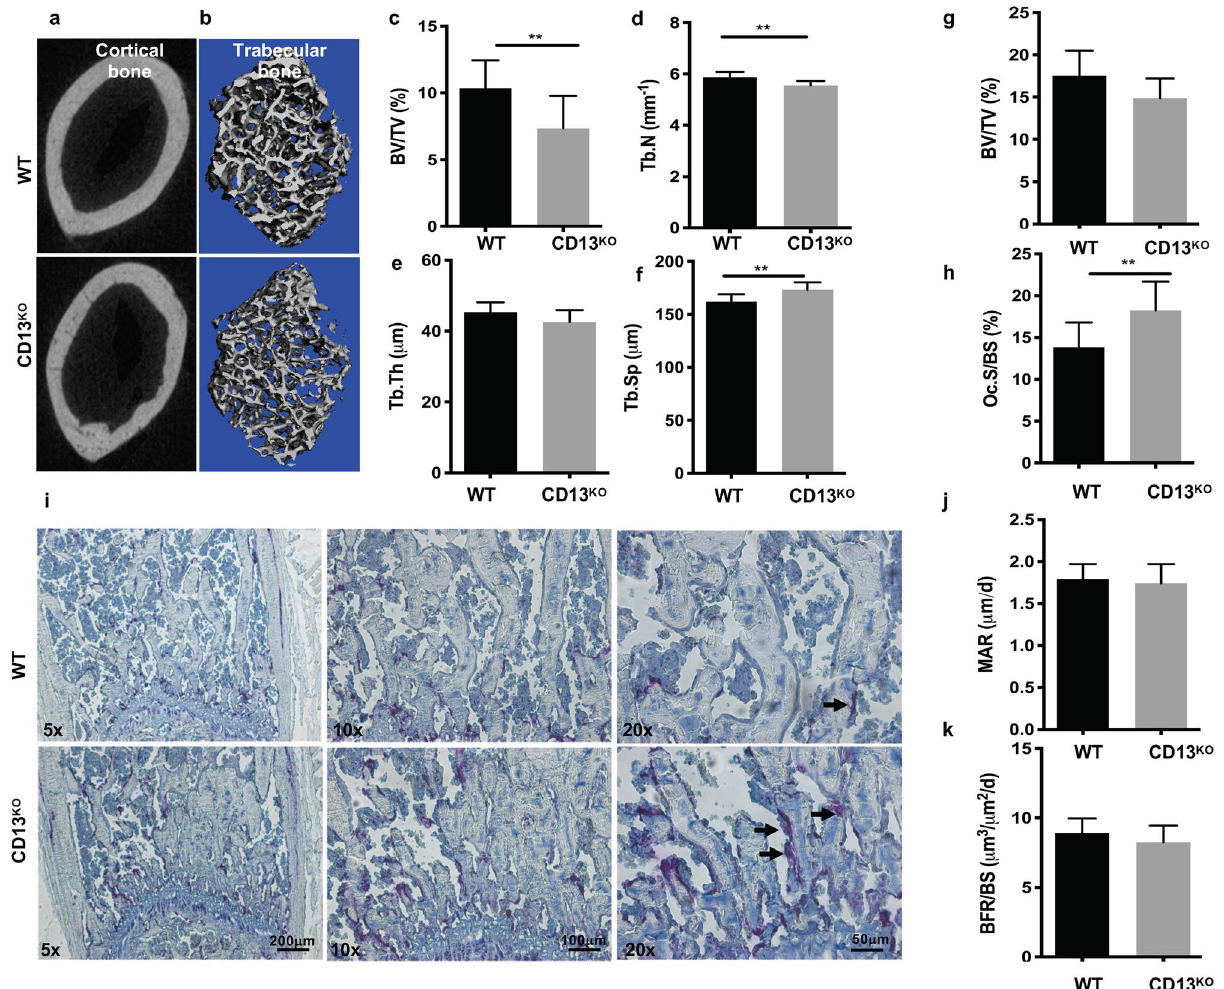
femurs with ( g ), BV/TV(%), ( h ) Oc.S/BS; % OCs per bone surface ( i ), histochemical detection of TRAP + osteoclasts (purple, indicated by the arrow). ( j ) Mineral apposition rate (MAR), ( k ) Bone formation rate (BFR/ BS) measured by Osteomeasure software (OsteoMetrics, Decatur, USA) (https:// www. osteo metri cs. com). All samples were scanned, reconstructed, and analyzed in a Scanco µCT40 running Evaluation Program V6.6 (http:// www. scanco. ch/ en/ syste ms- solut ions/ softw are. html). Histochemical analysis of TRAP + osteoclasts in bone sections were imaged with Zeiss fluorescence inverted microscope and analyzed by using Zeiss Zen 2.0 Pro blue edition software (https:// www. zeiss. com/ conte nt/ dam/ Micro scopy/ Downl oads/ Pdf/ FAQs/ zen2- blue- editi on_ insta llati on- guide. pdf). Scale bars-×5; 200 µm, ×10; 100 µm, ×20; 50 µm. Data represents ± SD. (N = 6; WT, N = 7; CD13 KO . **p <